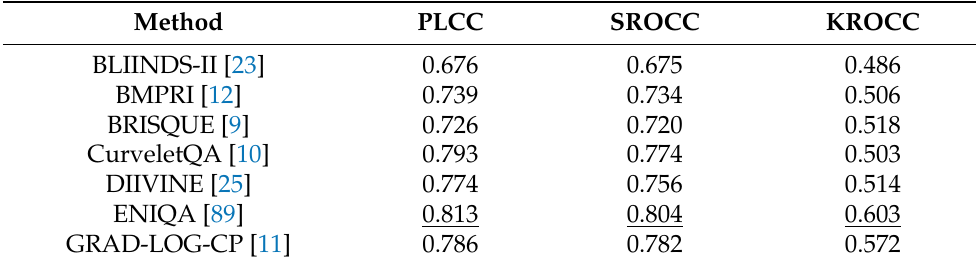
Table 8. Comparison to the state-of-the-art in the SPAQ [47] database. Median PLCC, SROCC, and KROCC values were measured over 100 random train–test splits. The best results are in bold and the second-best results are